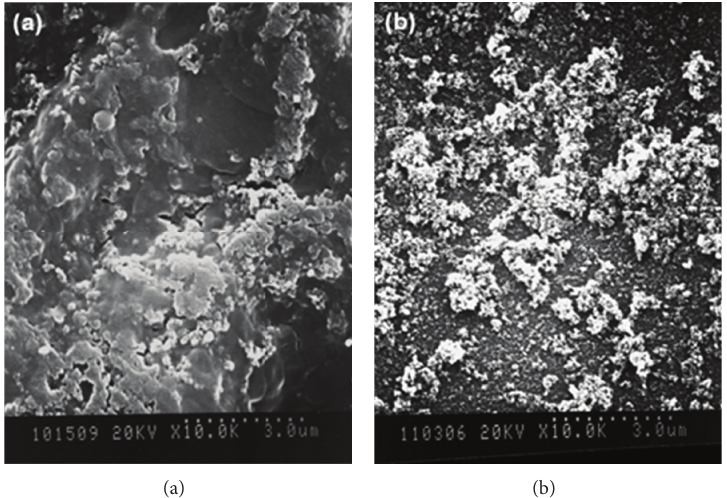
Figure 8: Surface of the UF membrane after ultrafiltration (10KD, magnified 10000x), (a) with 0wt% TiO 2 and (b) with 10wt% TiO 2